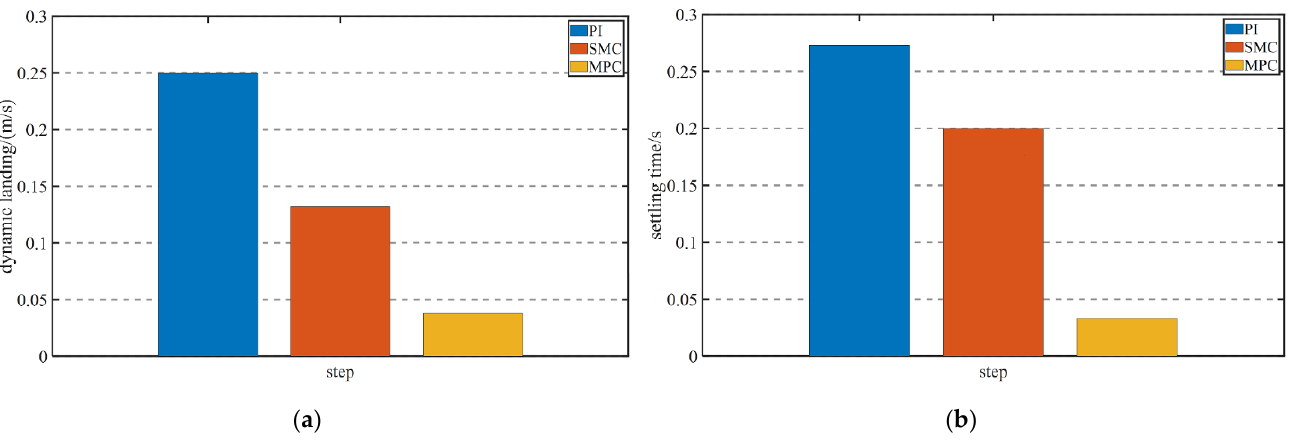
Figure 18. Comparison of the dynamic landing and the settling times of the three controllers under load variation: ( a ) Dynamic landing, and ( b ) Settling time.